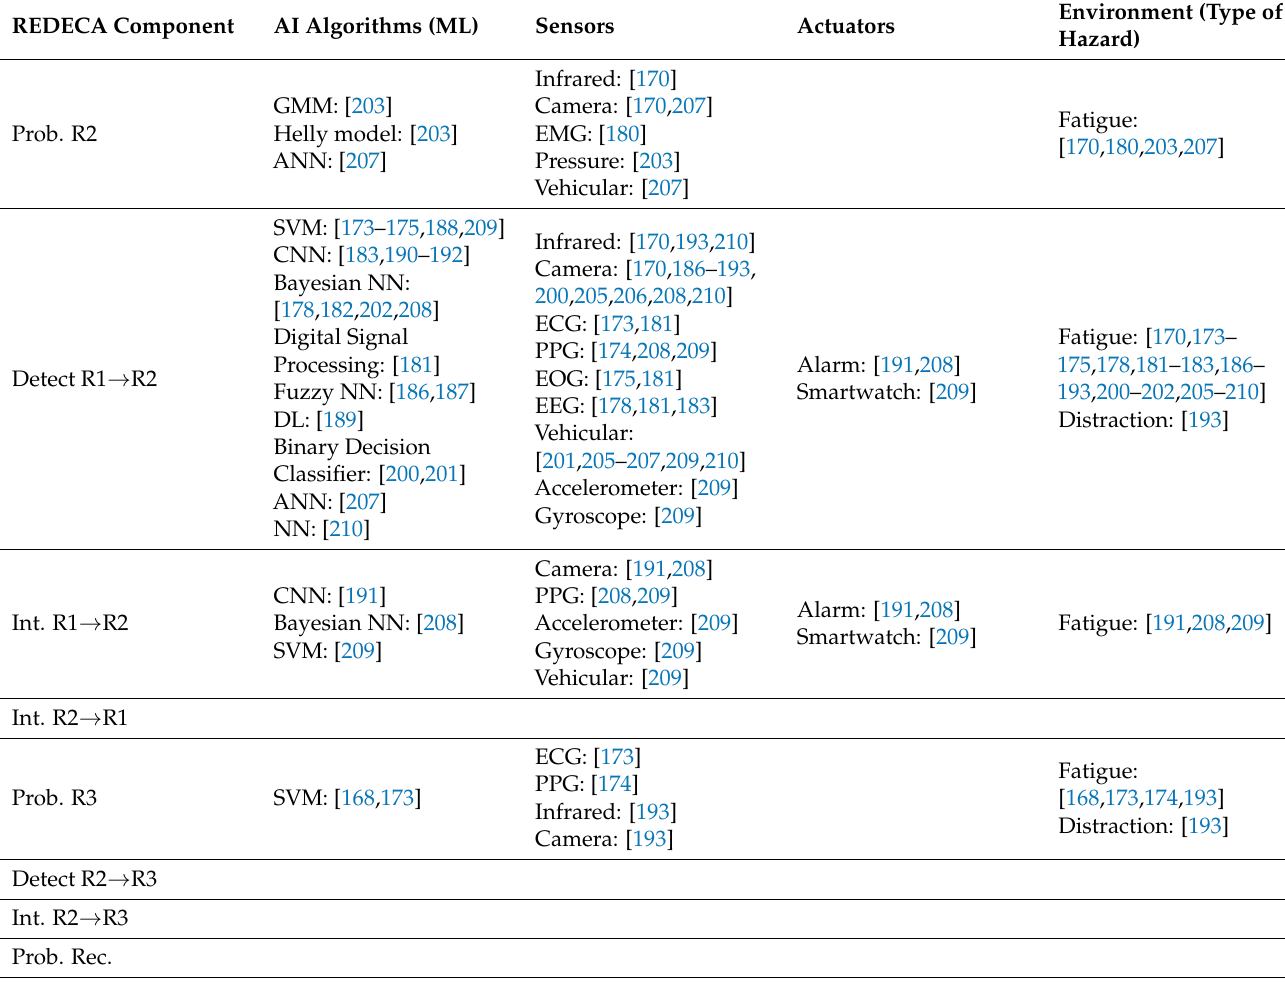
Table 7. Transportation AI/OSH algorithm, sensor and actuator research organized by the REDECA framework. Major technologies described by each paper is mentioned and linked to the relevant papers [159–210]. Summary of each paper is found in Appendix